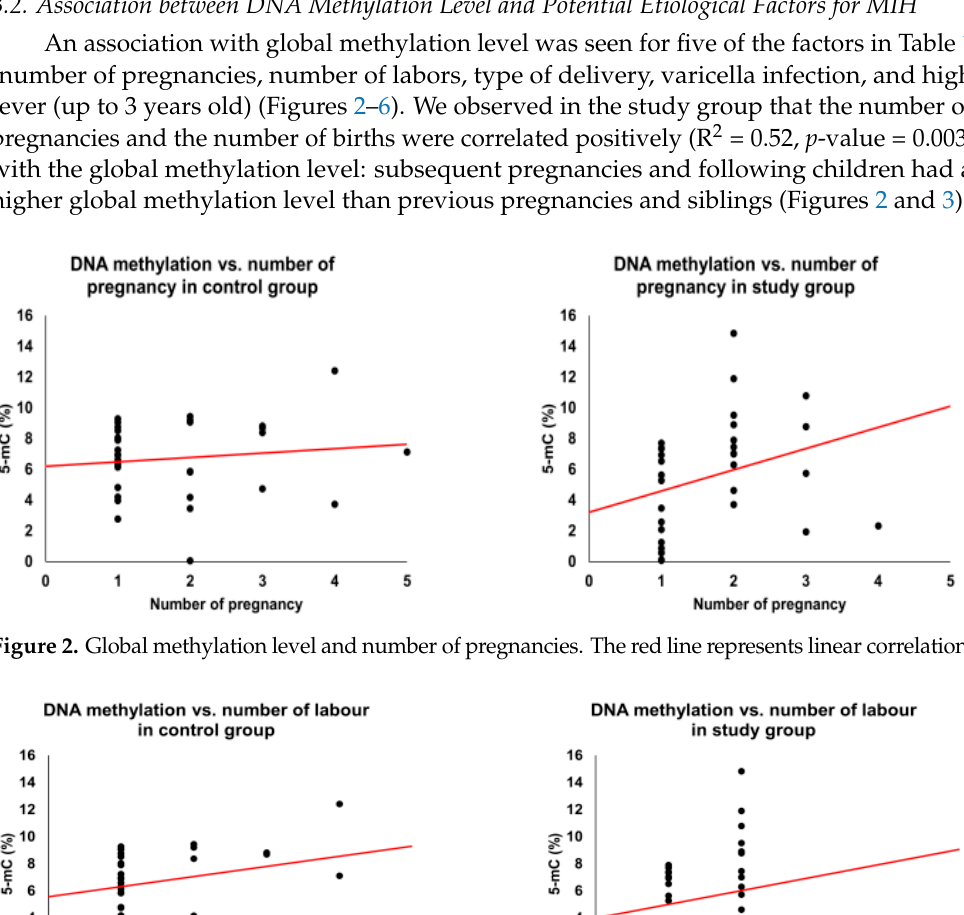
Figure 3. Global methylation level and number of labors. The red line represents linear correlation.